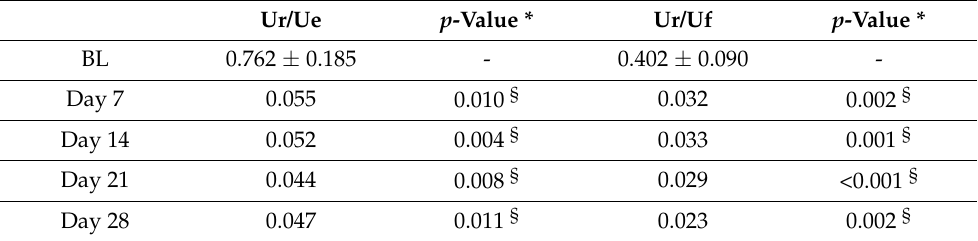
N = 42. The data were gathered by cutometry in area A1 (= treated with Emollient 1) and are presented as arithmetic means. BL = Baseline value (absolute mean ± SD) before first product application; Ur/Ue = net elasticity; Ur/Uf = ratio of elastic recovery to distensibility. * For mean change from baseline, paired t -test. § Significant if p < 0.0125 (Bonferroni correction). Note: An increase in Ur/Ue and Ur/Uf reflects improved elasticity properties of the